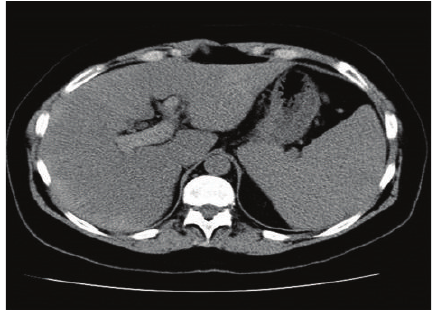
Figure 1: CT demonstrating portal thrombosis.